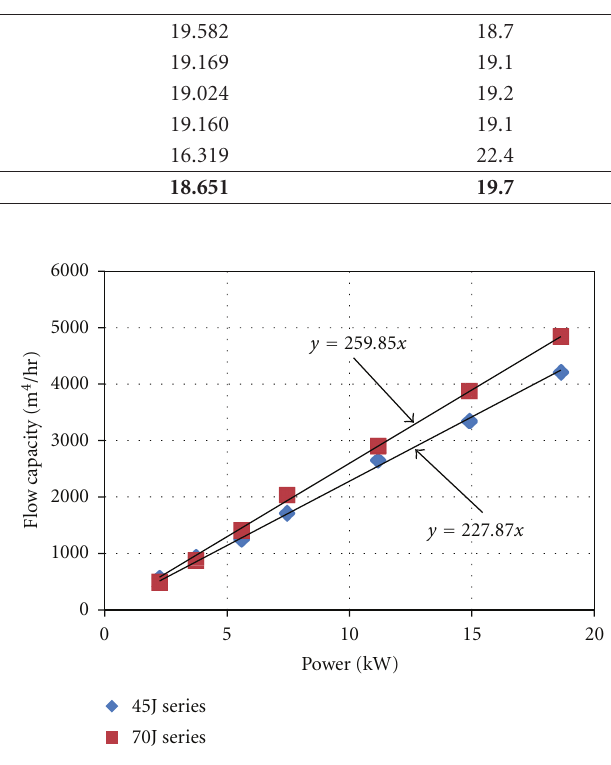
Figure 3: Flow capacity rate as function of pump size for two series of